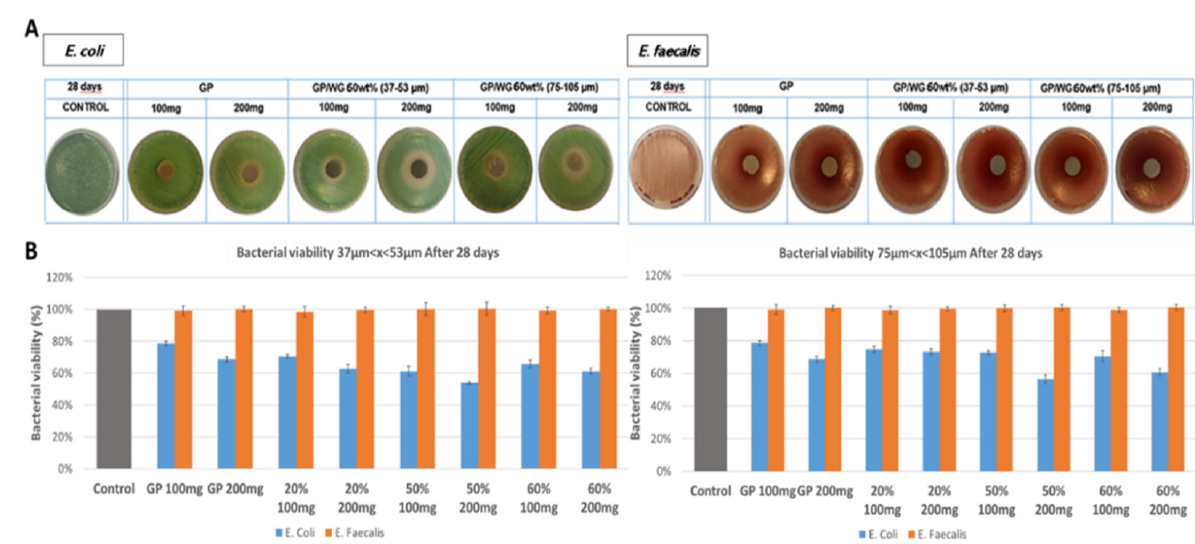
Figure 7. A representative image of bacterial plates ( A ) of E. coli and E. faecalis in presence of GP and GP/WG 50 wt% after 28 days curing time for fine and coarse series. ( B ) shows bacterial viability for both series.